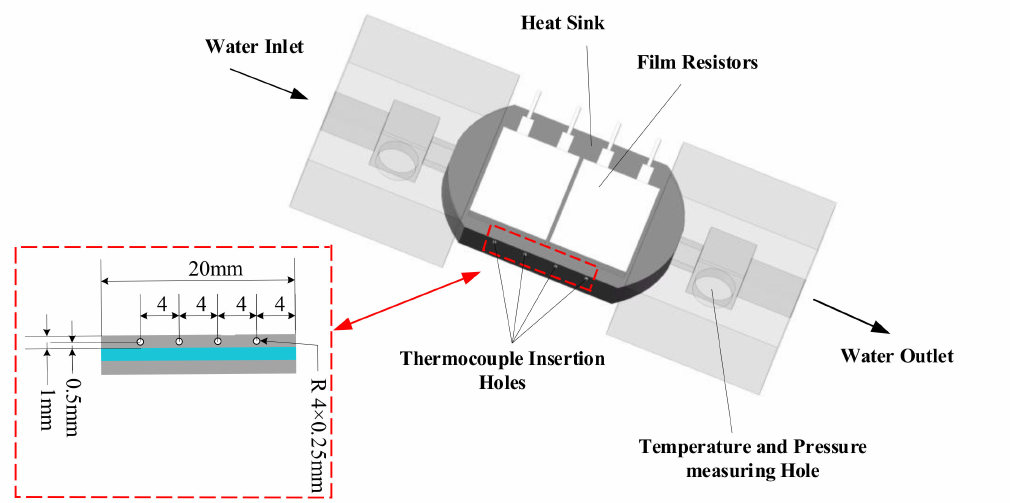
Figure 18. Assembly drawing of the heat sink ( right ) and location of four temperature measuring holes ( left